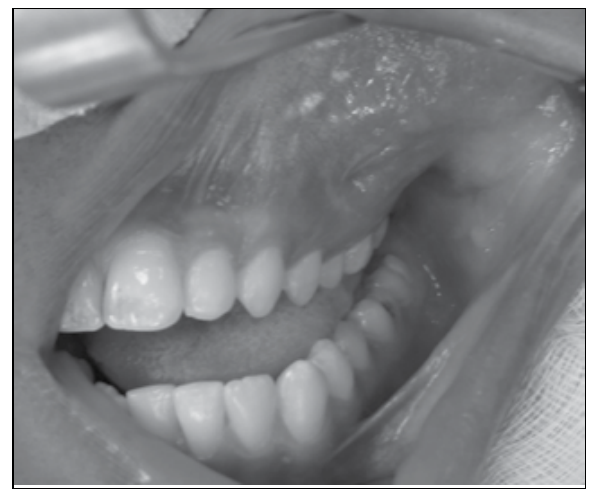
Figura 1 – Aspecto clínico da lesão